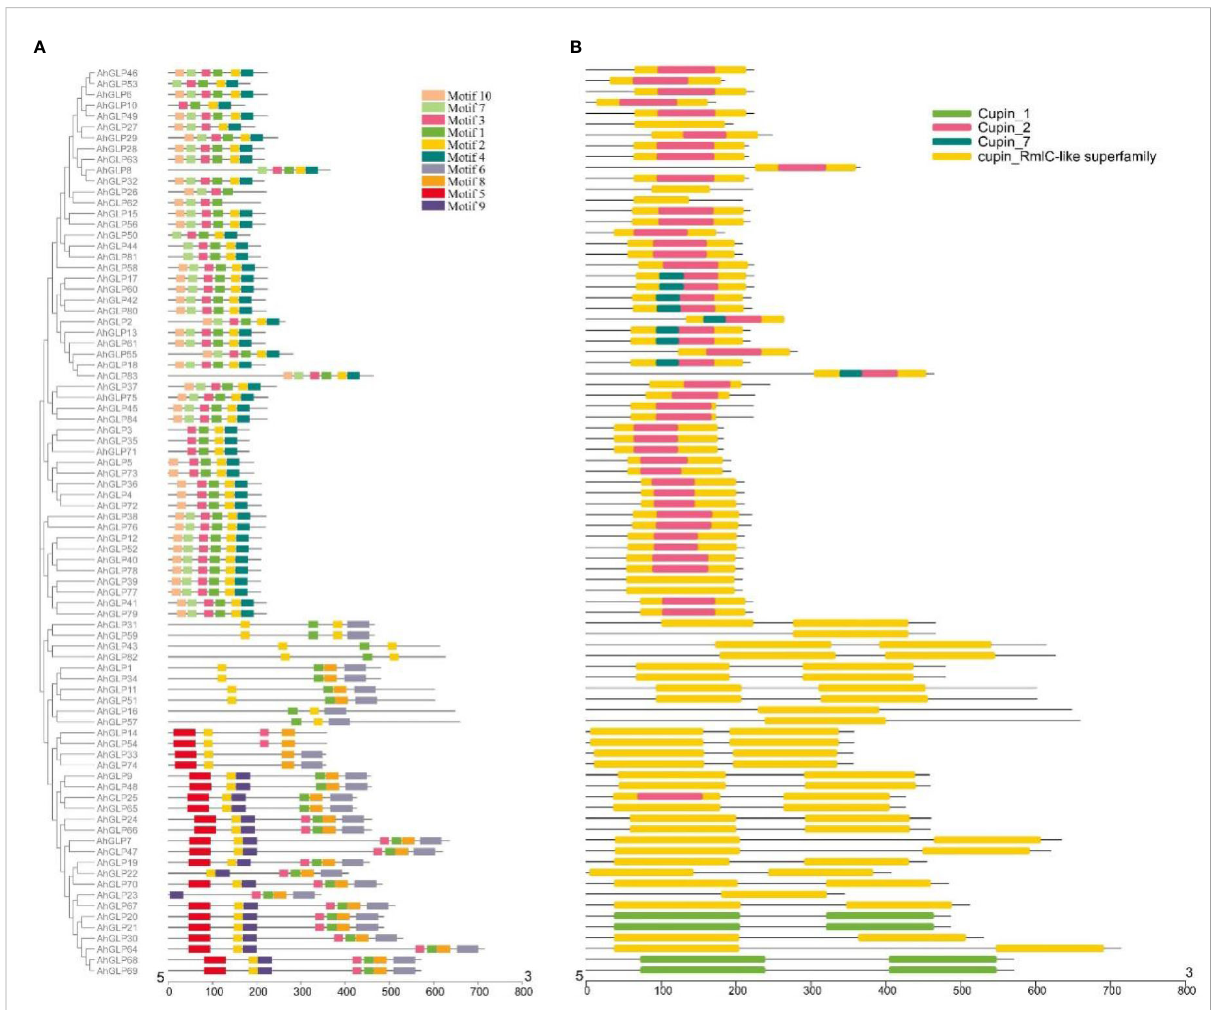
FIGURE 3 Conserved motifs distribution patterns (A) and presence of cupin domains (B) in Arachis hypogaea Germin-like proteins ( AhGLPs ). Commonly shared motifs among genes tend to cluster in the same groups, referring to their similar